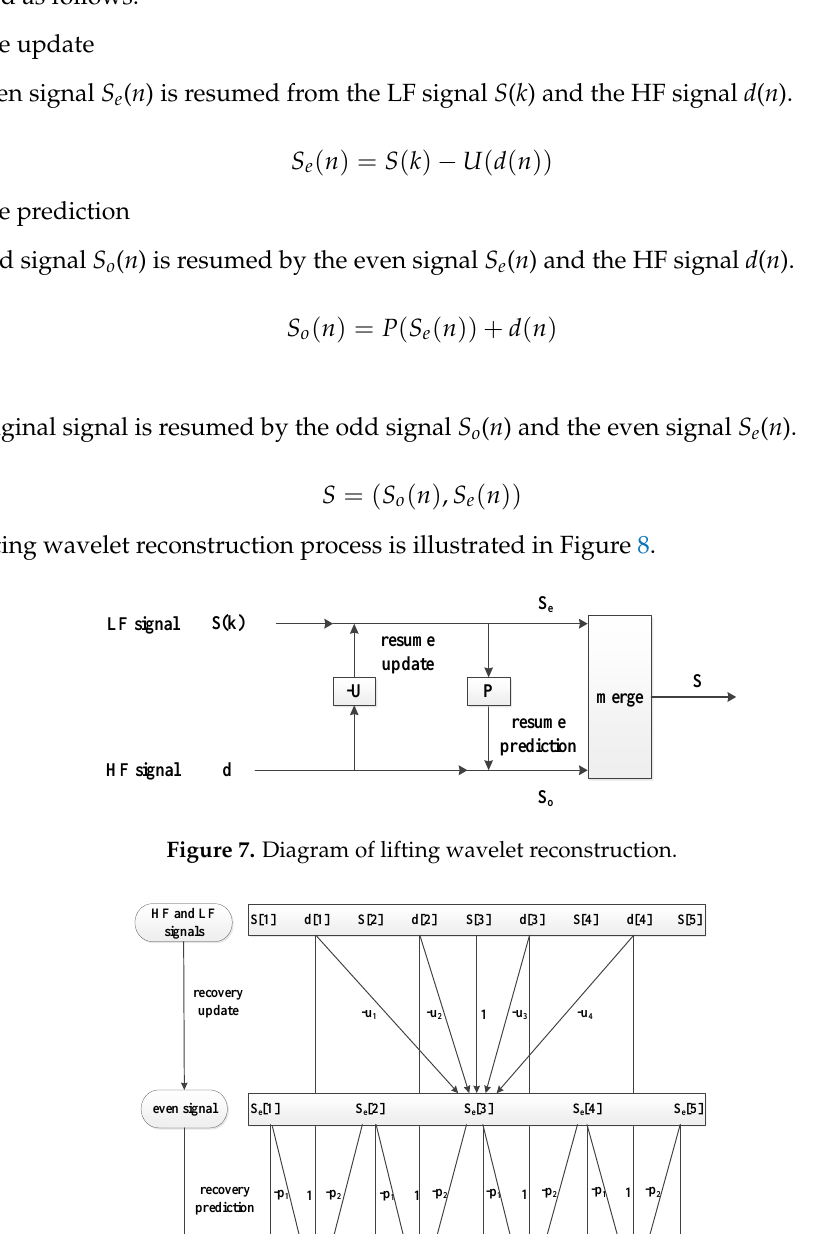
Figure 8. Rendering of lifting wavelet reconstruction.